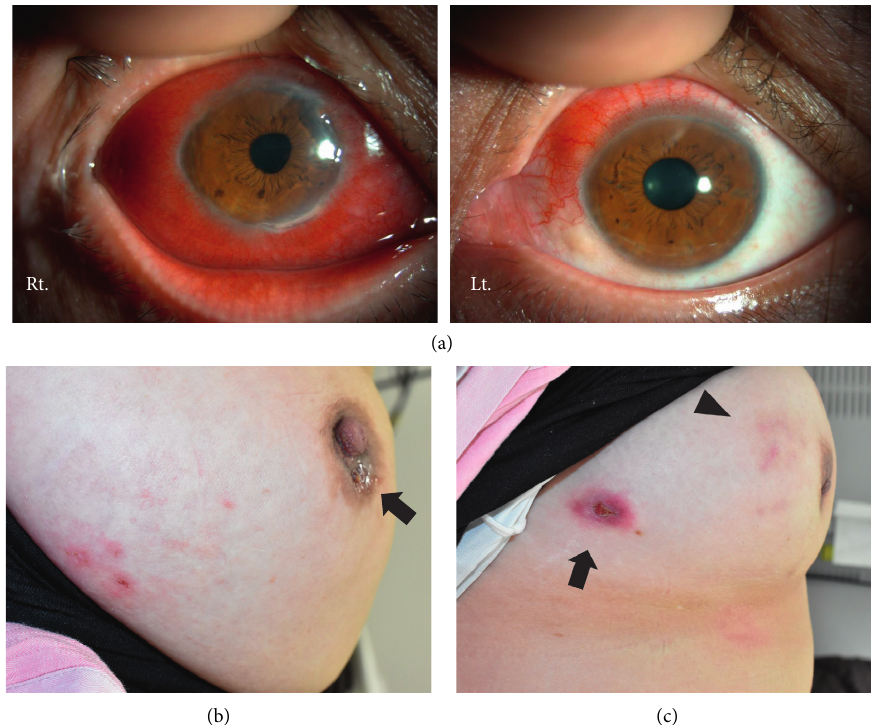
Figure 1: (a) Clinical pictures of the patient’s bilateral necrotizing scleritis. (b) Discharge from her nipples (arrow). (c) Pale erythema (arrowhead) and a skin ulcer (arrow) on the right